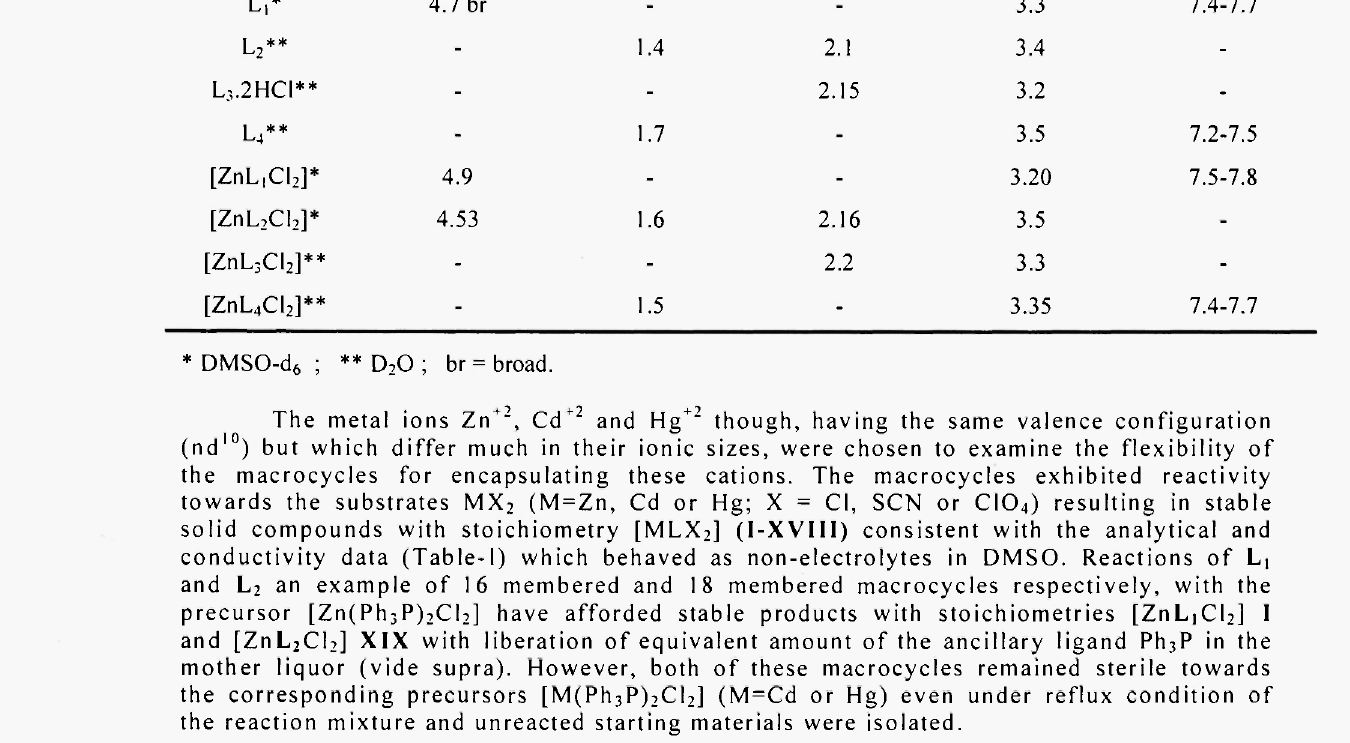
Table-Ill: 'H NMR Data (δ in ppm) of the macrocycles and their Zn(II) complexes